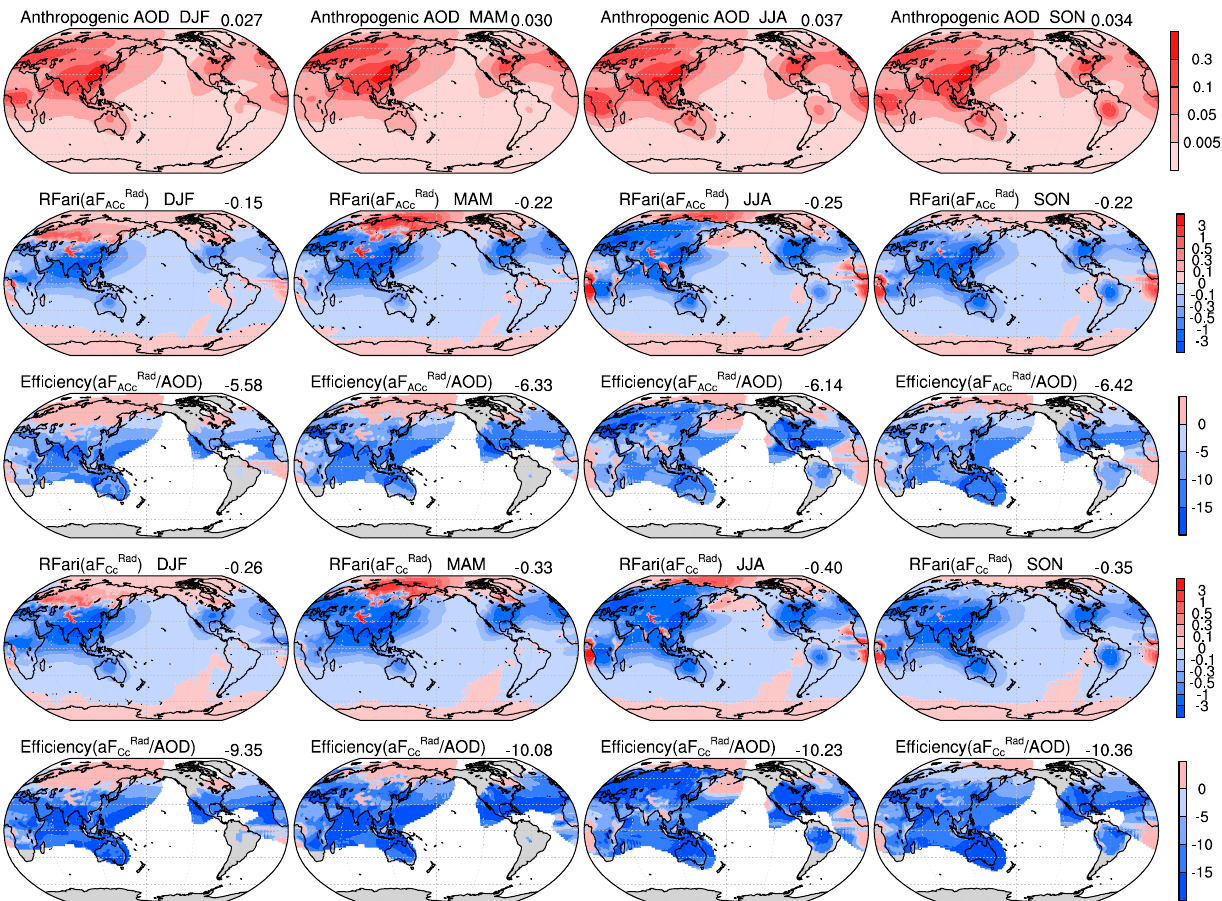
Figure 5. Seasonal maps for the present-day (year 2000) anthropogenic aerosol optical depth (AOD) ( top row), the normal instantaneous radiative forcing from aerosol–radiation interactions (RFari = aF ACc , second row) and corresponding efficiency ( third row), and the RFari without the natural aerosol radiative effect (RFari = aF Cc , fourth row) and corresponding efficiency (bottom row). Season labels (DJF, MAM, JJA, and SON) are given at the top. The area of low anthropogenic aerosol burden (AOD < 0.005) is masked.